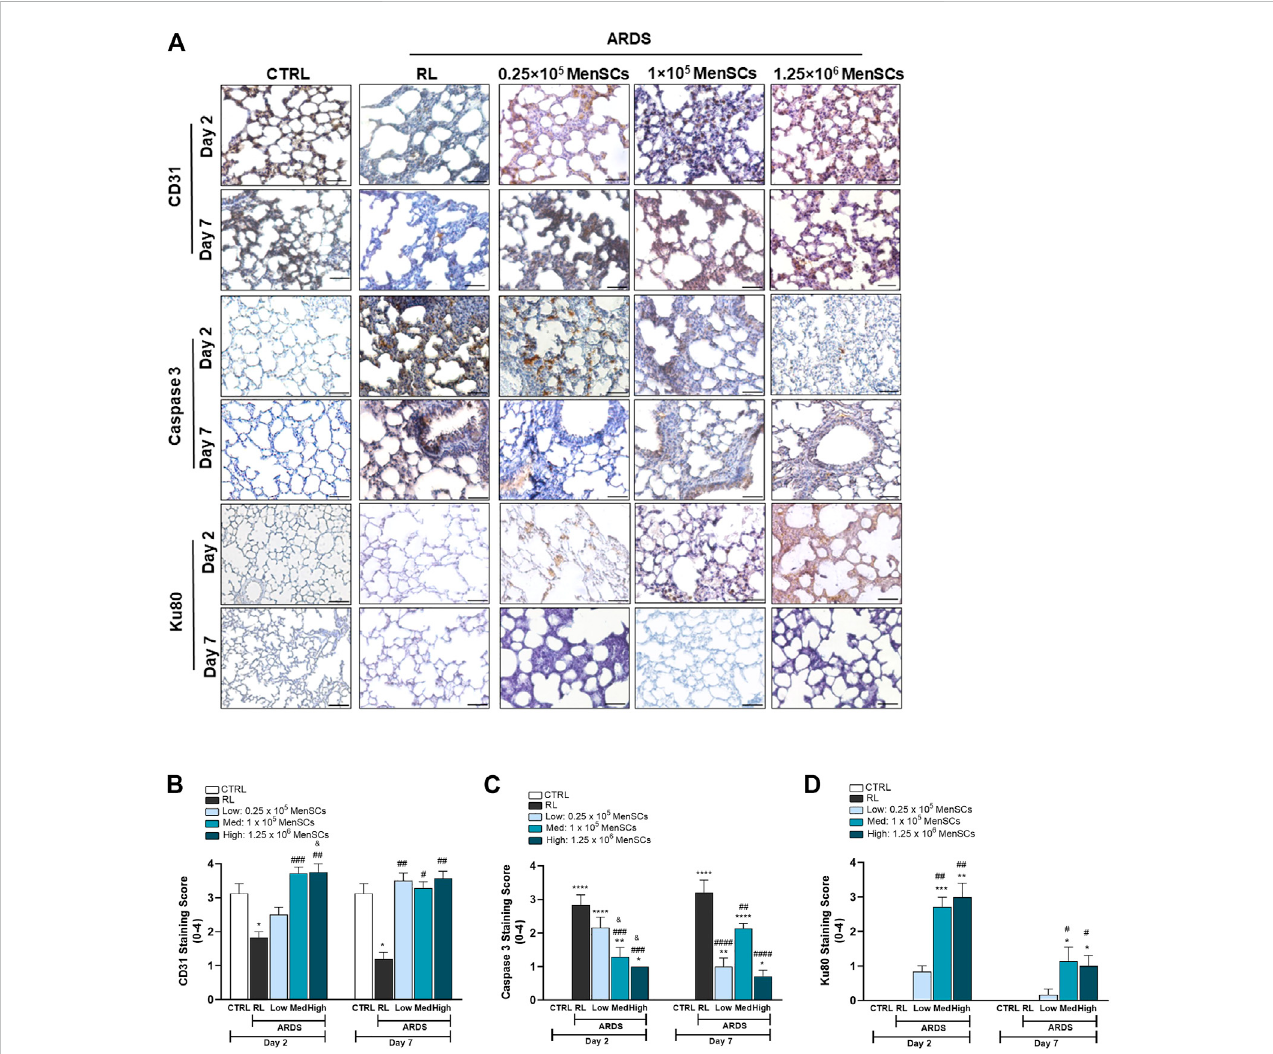
staining with anti-CD31, anti-caspase-3 and anti-Ku80 antibodies for angiogenesis, apoptosis, and persistence evaluation, respectively. Scale bar, 100 μ m. Semiquantitative scoring for (B) CD31, (C) caspase-3 based and (D) Ku80. Values are expressed as the mean ± standard error of the mean (n = 6 – 8, animals per group). *Signi fi cantly different from the CTRL group (* p ≤ 0.05, ** p ≤ 0.01; **** p ≤ 0.0001). # Different from the RL group ( # p ≤ 0.05, ## p ≤ 0.01, ### p ≤ 0.001, #### p ≤ 0.0001). & Different from the low MenSCs dose ( & p ≤